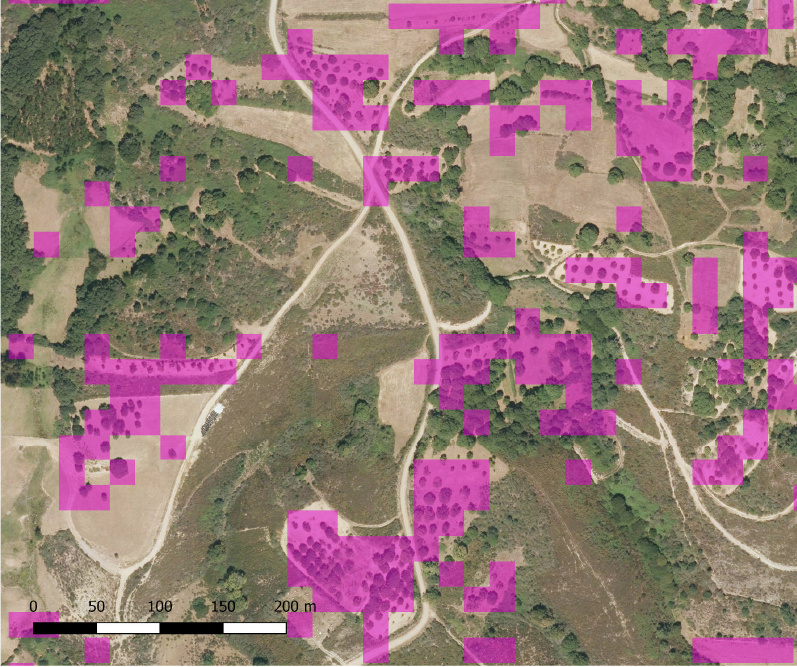
Figure 7. Detail of the chestnut plantation map created using prediction Model 2. Image source: PNOA image [56].